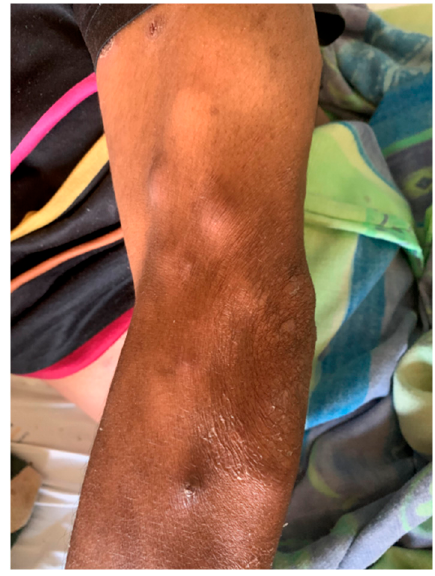
Figure 2. Patient’s left upper arm and elbow, showing dermal nodules.